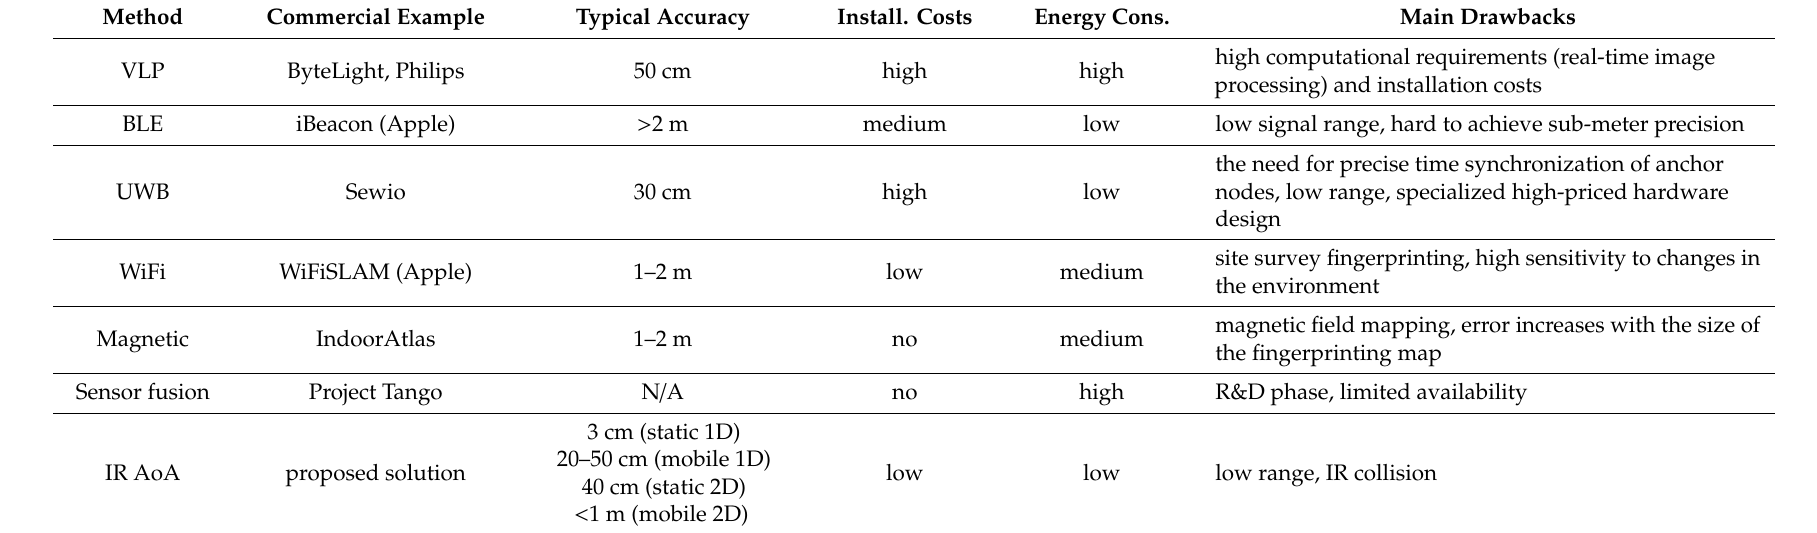
Table 2. Comparison of related indoor localization